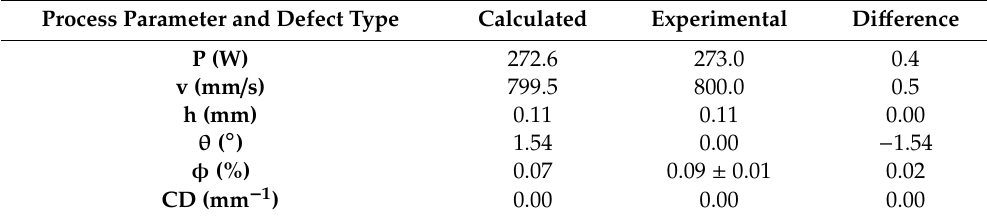
Table 6. Optimization results